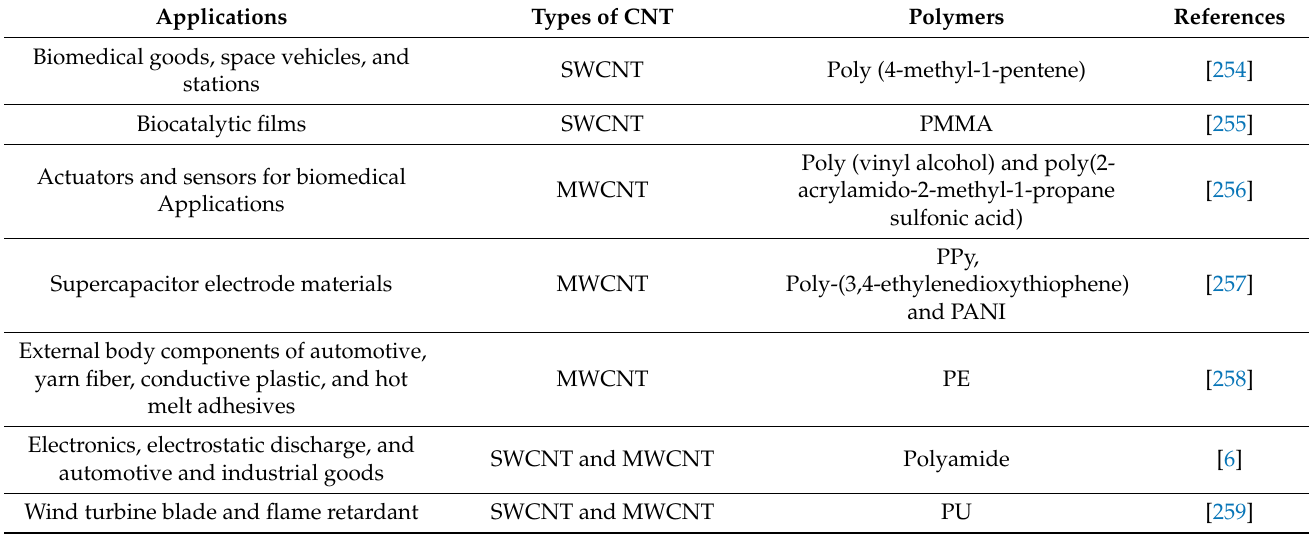
Table 11. Recent progress of CNT–polymer